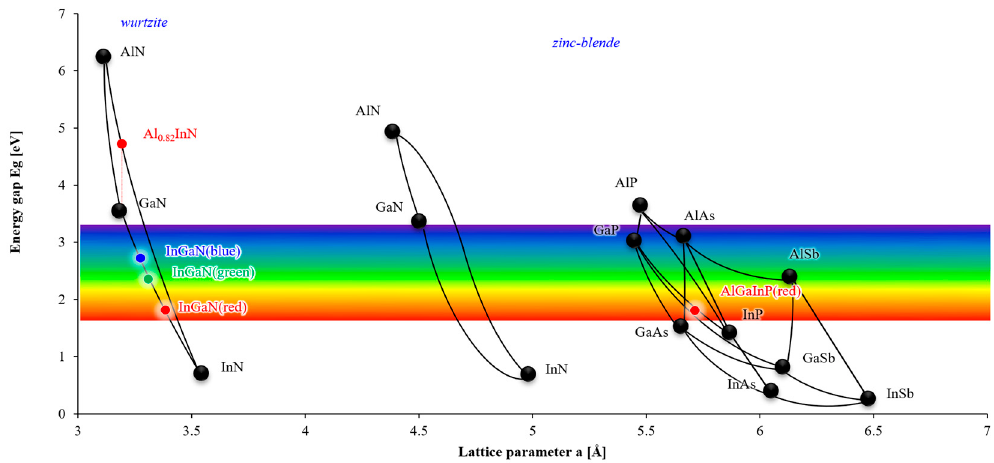
Figure 1. Band gap energy and lattice constant of compound semiconductors [8,9].